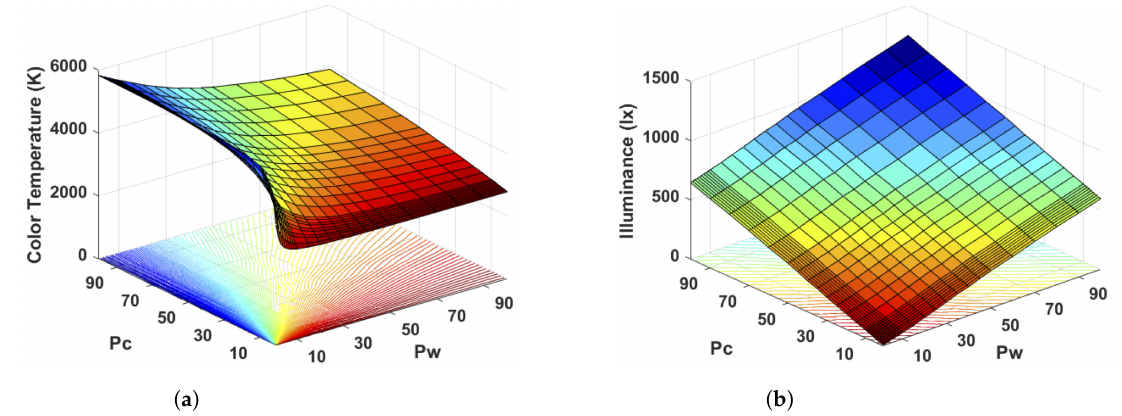
Figure 7. Average surface curves, representative of the entire family of LED light sources and the respective level sets; ( a ) CCT trend as a function of the power supply percentage; ( b ) illuminance trend as a function of the power supply